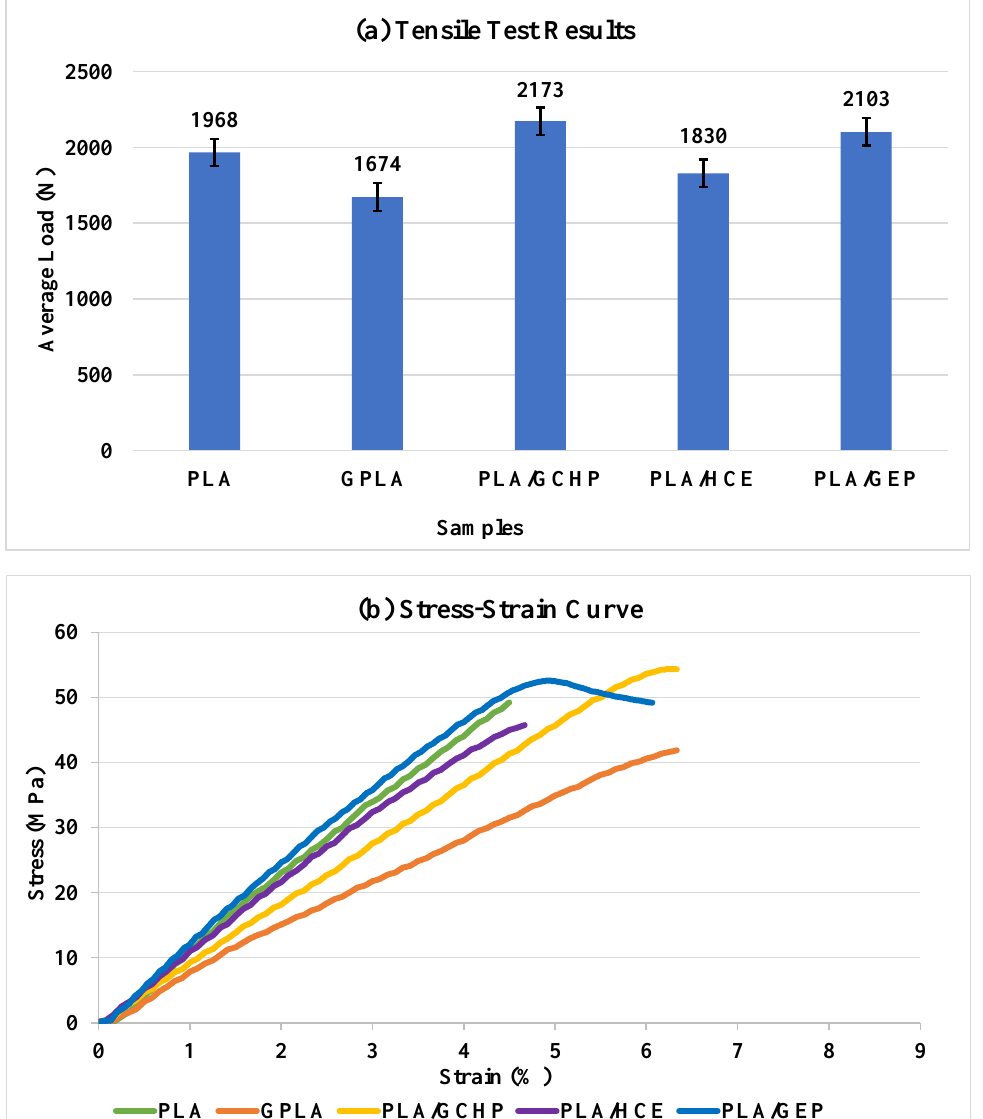
Figure 7. Comparative tensile test results: ( a ) Results from tensile testing with standard deviation as error bars; ( b ) stress–strain curve.